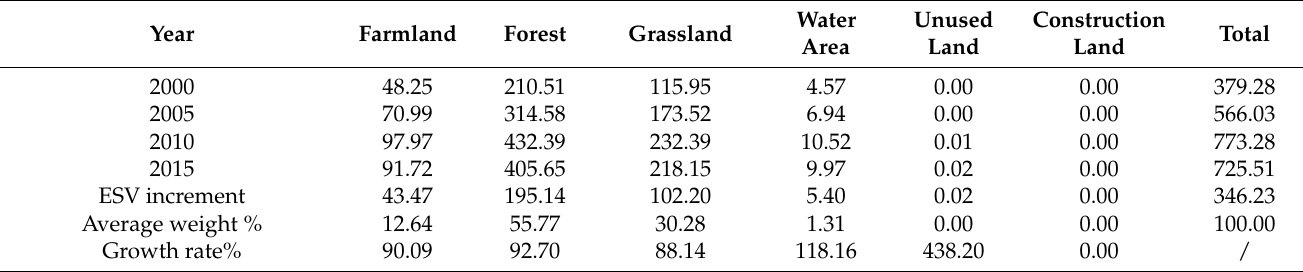
Table 6. Changes in the value of ecosystem services in different land types in the Qinba Mountains from 2000 to 2015 (CNY 100 million).